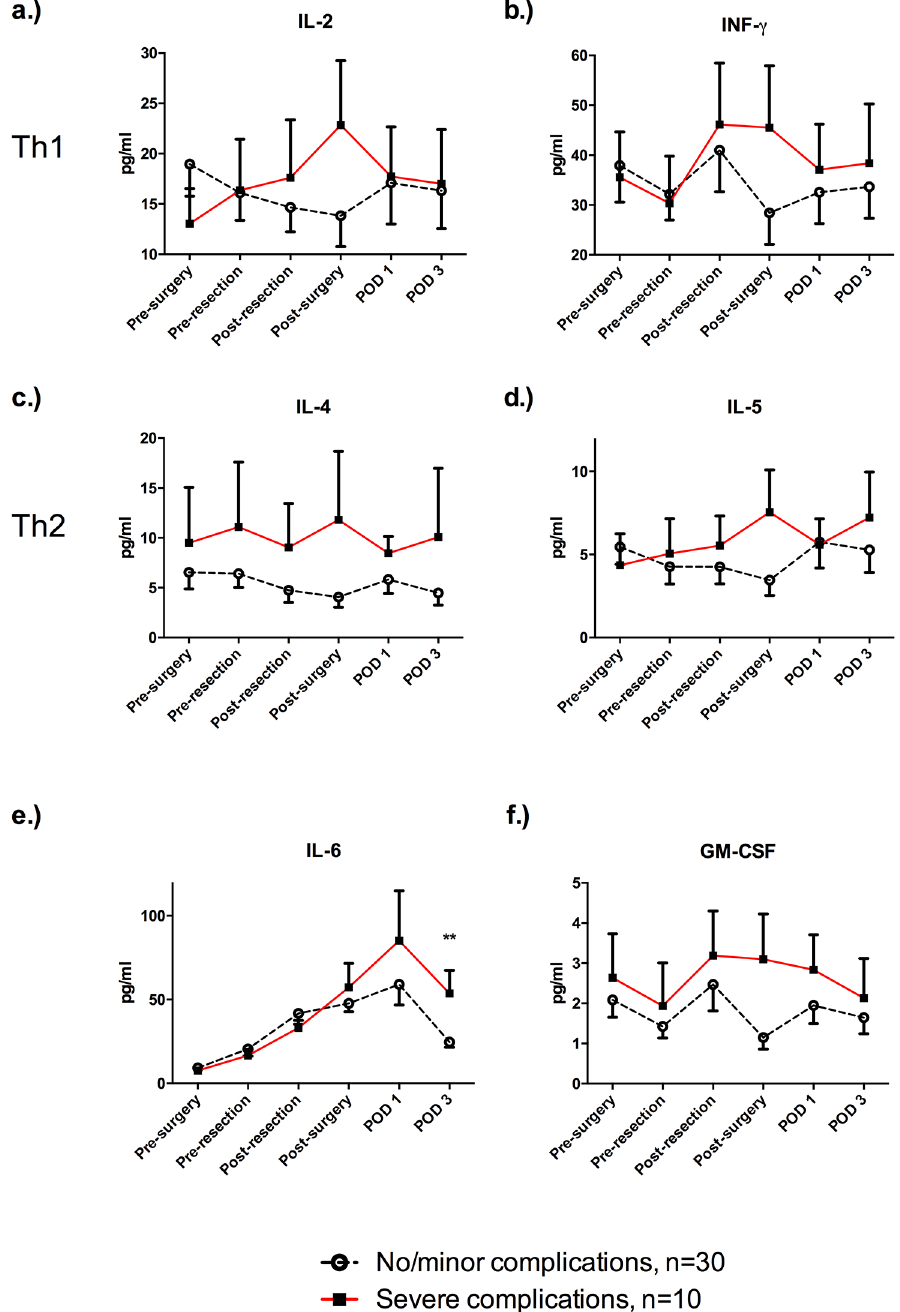
Fig 3. Cytokines during liver resection. ClassicalTh1 (A, B) and TH2 cytokines (C, D) were measured perioperatively. Even thoughthere was a trend towards highervalues of IL-2 (A), INF-y (B), IL-4 (C), IL-5 (D) and GM-CSF (F) perioperatively, the observeddifferencesdid not reach statistical significance. (E) Patients with severe post-operativecomplication had significantly higherlevels of IL-6, measuredPOD3 (24.6 (3.1) pg/ ml vs. (53.7 (13.8) pg/ml; p = 0.004). Data are expressedas means with standard error of the mean (SEM) and comparisonwas performed by using an unpairedt-test. ** p < 0.01.